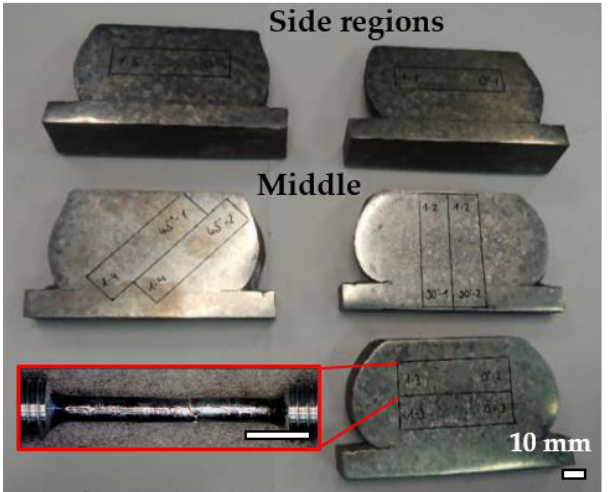
Figure 3. Illustration of locations, orientations and dimensions of tensile specimens analyzed in the present study (scale bars are 10 mm); example demonstrated for sample no. 1.